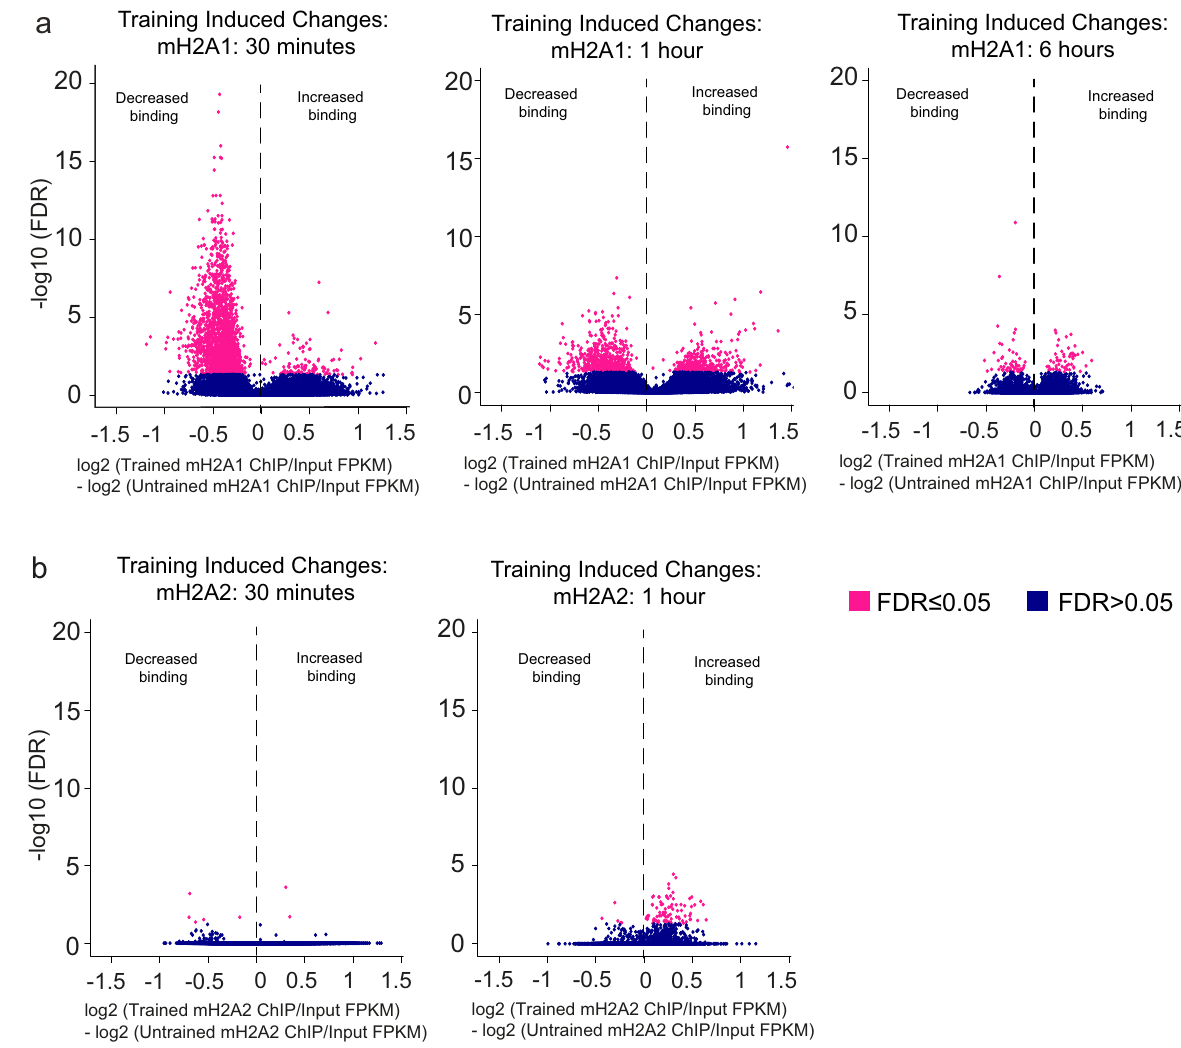
Fig. 5 mH2A1, but not mH2A2 binding at broad domains is dynamically regulated during learning. a Differentially enriched regions (FDR ≤ 0.05) in untrained compared to trained mice were identi fi ed using DiffBind analysis of mH2A1 consensus peaks (using epic2 peak caller) 30 min, 1 h and 6 h after fear conditioning. b Differentially enriched regions (FDR ≤ 0.05) in untrained compared to trained mice were identi fi ed using DiffBind analysis of mH2A2 consensus peaks (using epic2 peak caller) 30 min or 1 h after fear conditioning. Data are plotted as ChIP FPKM divided by Input